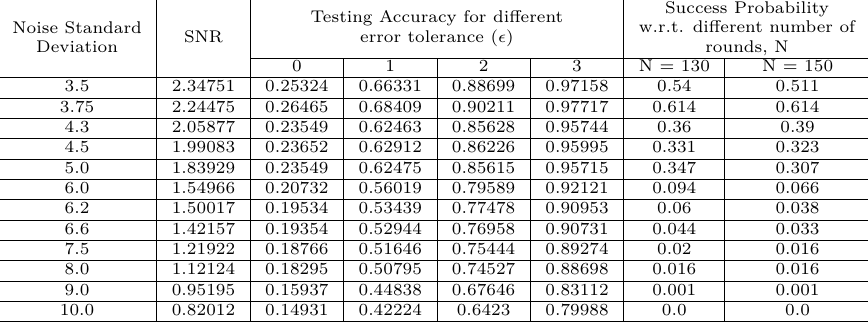
Table 8: Success Probability with respect to